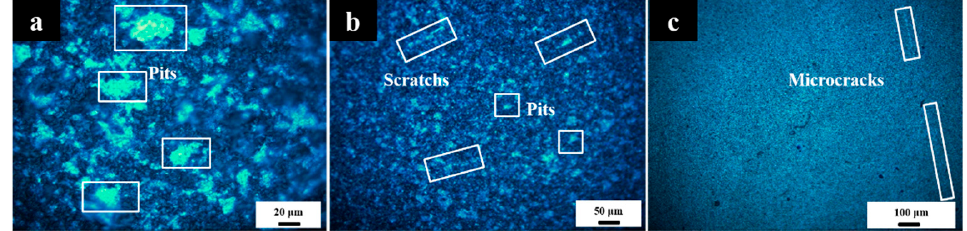
Figure 1. Crystal surface morphology after grinding with different abrasive particle size ( a ) 40 μ m; ( b ) 20 μ m; ( c ) 10 μ m. ( b ) 20 µ m; ( c ) 10 µ